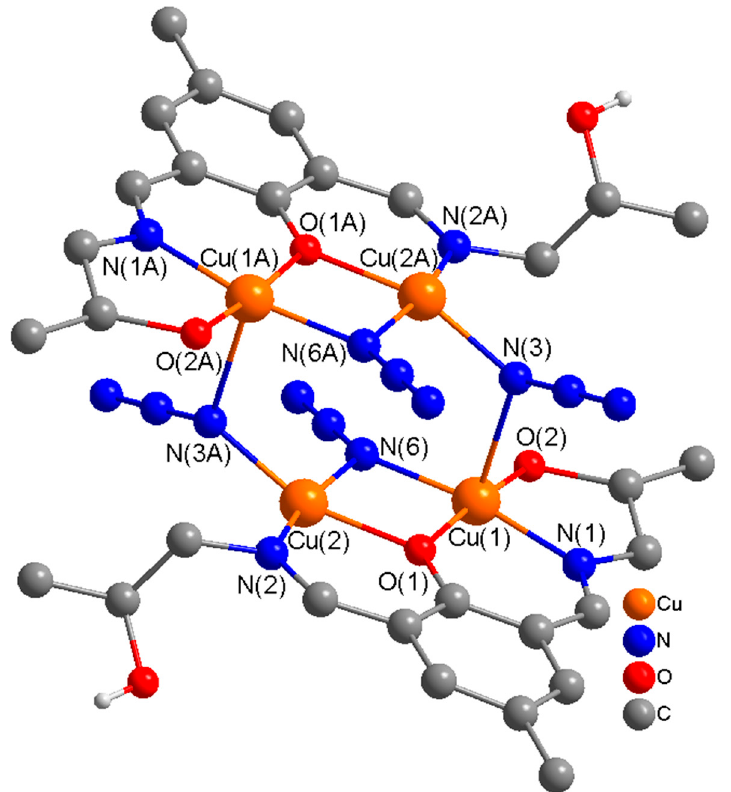
Figure 2. Molecular structure of a neutral centrosymmetric tetranuclear unit [Cu 4 (HL 2 − ) 2 (N 3 ) 4 ] ( 1 ) with numbering of atoms in the coordination environment. H atoms and solvent molecules are omitted for clarity. Atoms with A in their labels are symmetry generated.